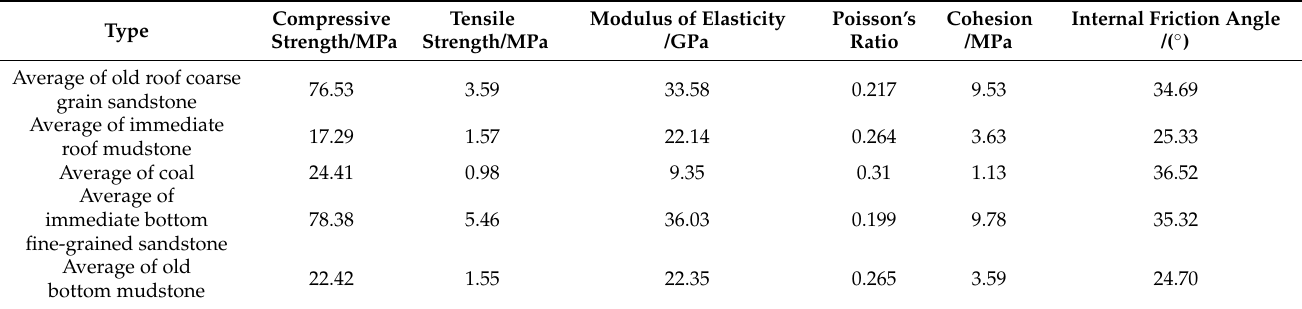
Table 2. Summary of mechanical parameters of the Sima mine roof and floor